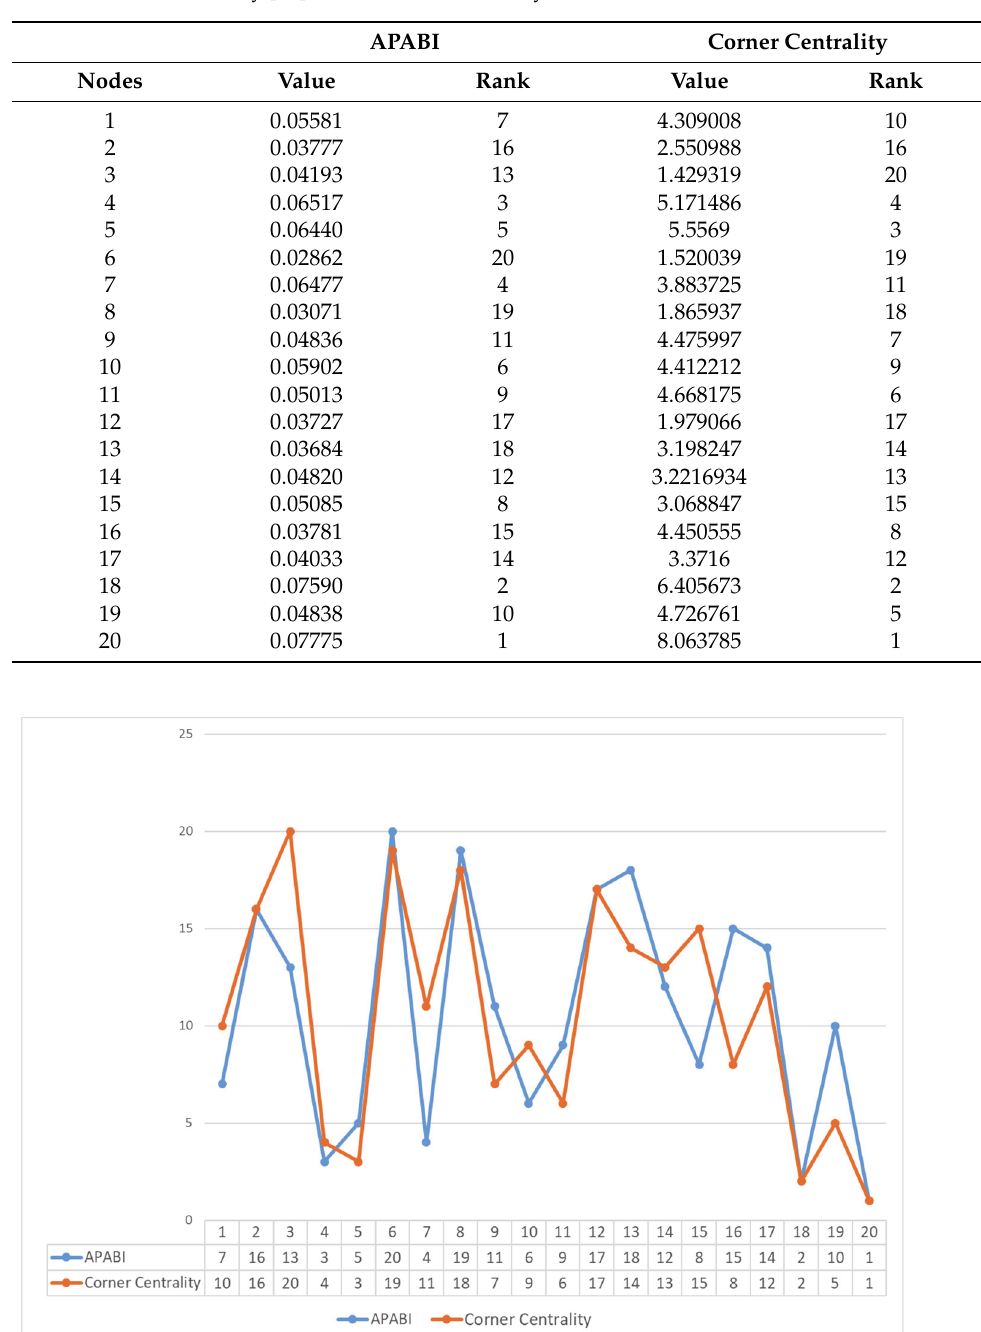
Table 4. APABI centrality [13] versus corner centrality.